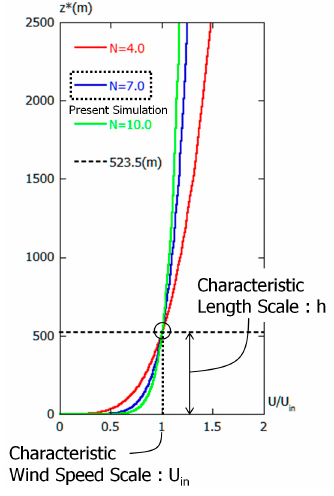
Figure 18. Inflow condition.